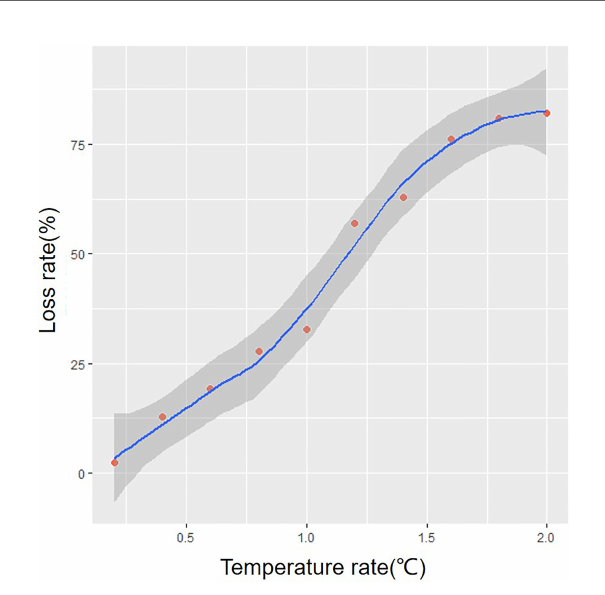
FIGURE 5 | Changes in the potential suitable habitat of Scomberomorus niphonius . (Blue indicates that the species was suitable for survival but is unsuitable now; yellow represents previously and now suitable habitats; red means that the species that did not fi t before and now shows fi tness).